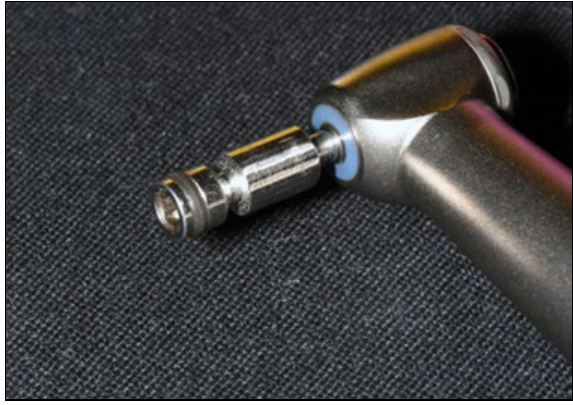
Figure 2. Application instrument with printed metallic shaft